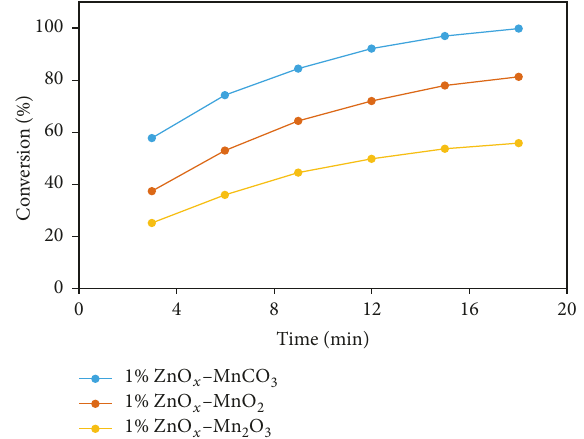
Figure 7: Graphical illustration of 1-phenylethanol oxidation using catalyst calcined at different calcination